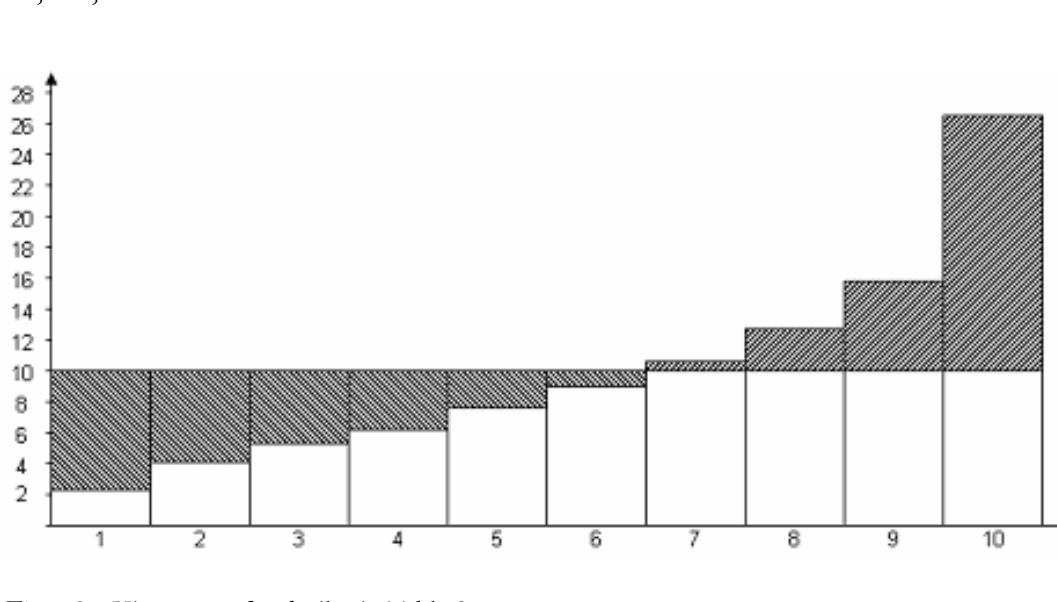
Figure 2 – Histograms for deciles in Table